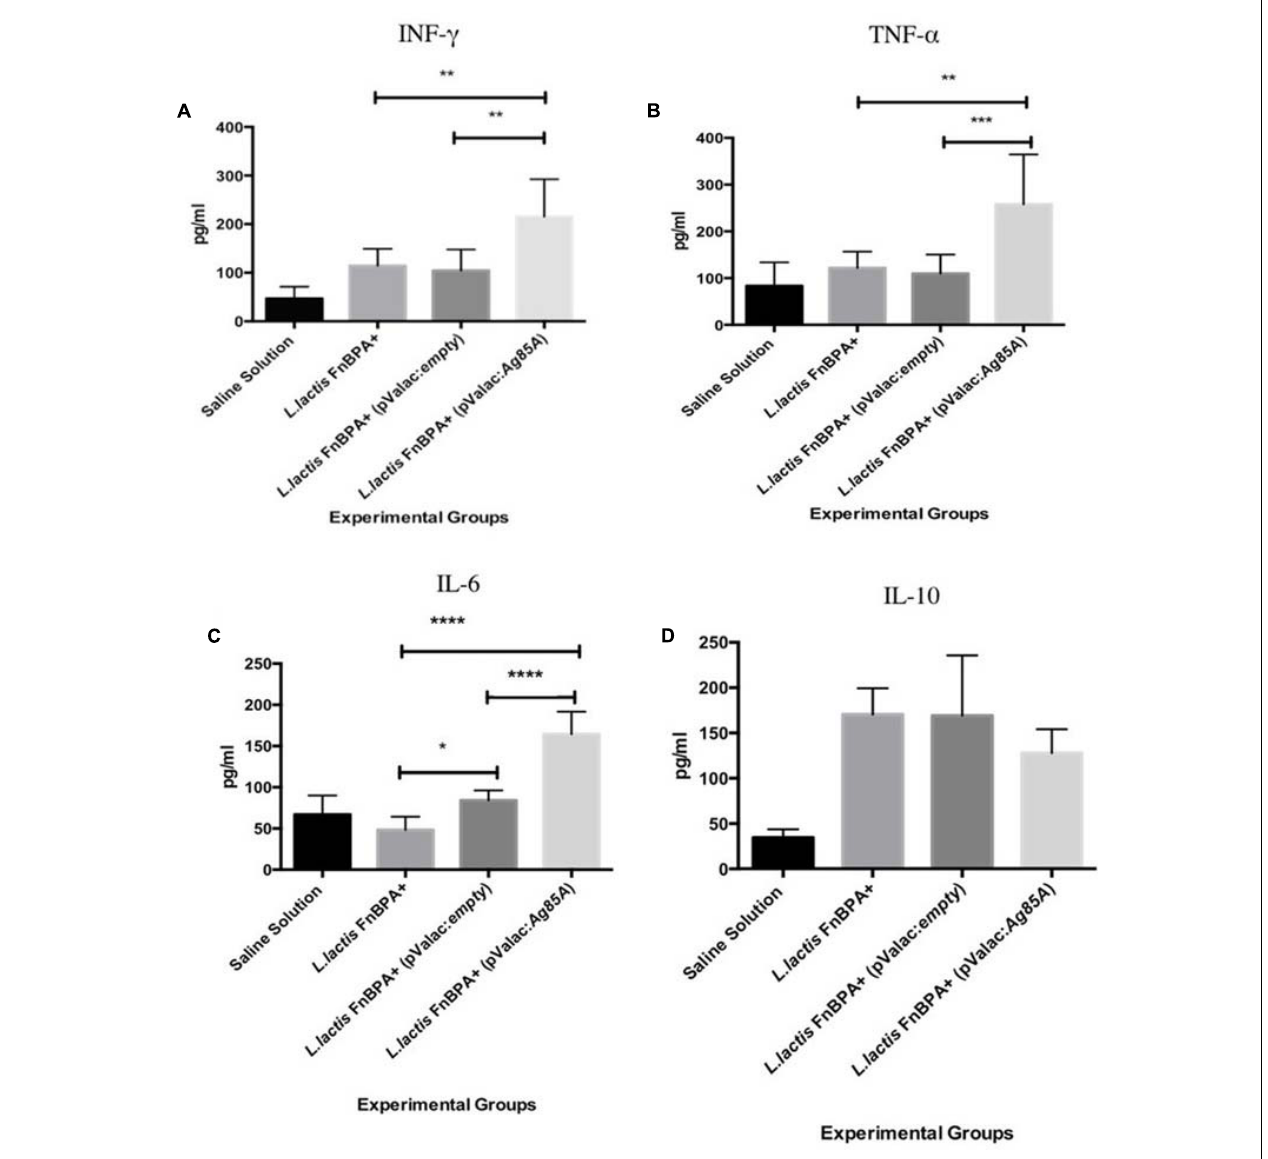
FIGURE 4 | Production of cytokines from spleen cells stimulated with recombinant Ag85A. Production levels of (A) INF- γ , (B) IL6, (C) TNF- α , and (D) IL-10 in cultured supernatants of spleen cells. Experimental groups: Saline Solution (negative control), Lactococcus lactis FnBPA + (negative control), L. lactis FnBPA + (pValac: empty ), and L. lactis FnBPA (pValac: Ag85A ). Data are shown as the mean ± SD. Two individual experiments were performed, five animals were used in each group for each individual protocol and each animal was analyzed individually. p -value: ∗ p < 0.05, ∗∗ p < 0.01, ∗∗∗ p < 0.001, and ∗∗∗∗ p <